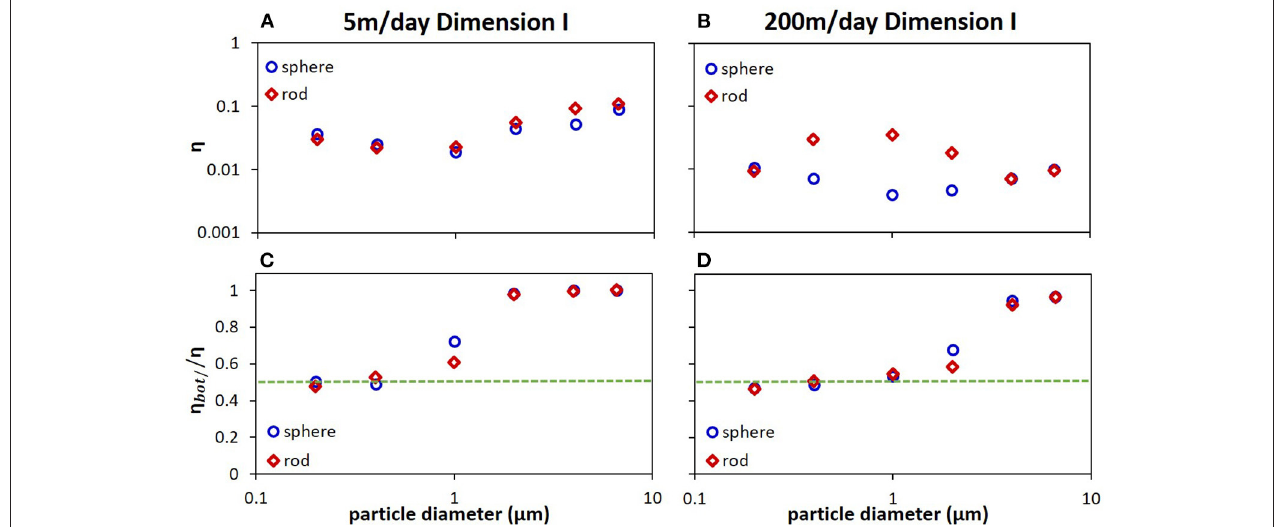
FIGURE 3 | Simulated collector efficiencies ( η ) and the ratios of particles attached on the bottom plate to the total attachment ( η bot /η ) as a function of particle size for polystyrene spheres (blue circles) and rods (dark red diamonds) from parallel plate model of Dimension I under favorable conditions at pore water velocity of 5 m/day (A,C) and 200 m/day (B,D) . The green dotted line illustrated where attachment on the top plate equaled to that on the bottom plate (i.e., η bot /η = 0.5). Flow direction was perpendicular to the direction of gravity. The statistical error was about 5–10%. Other simulation conditions were given in Table 1